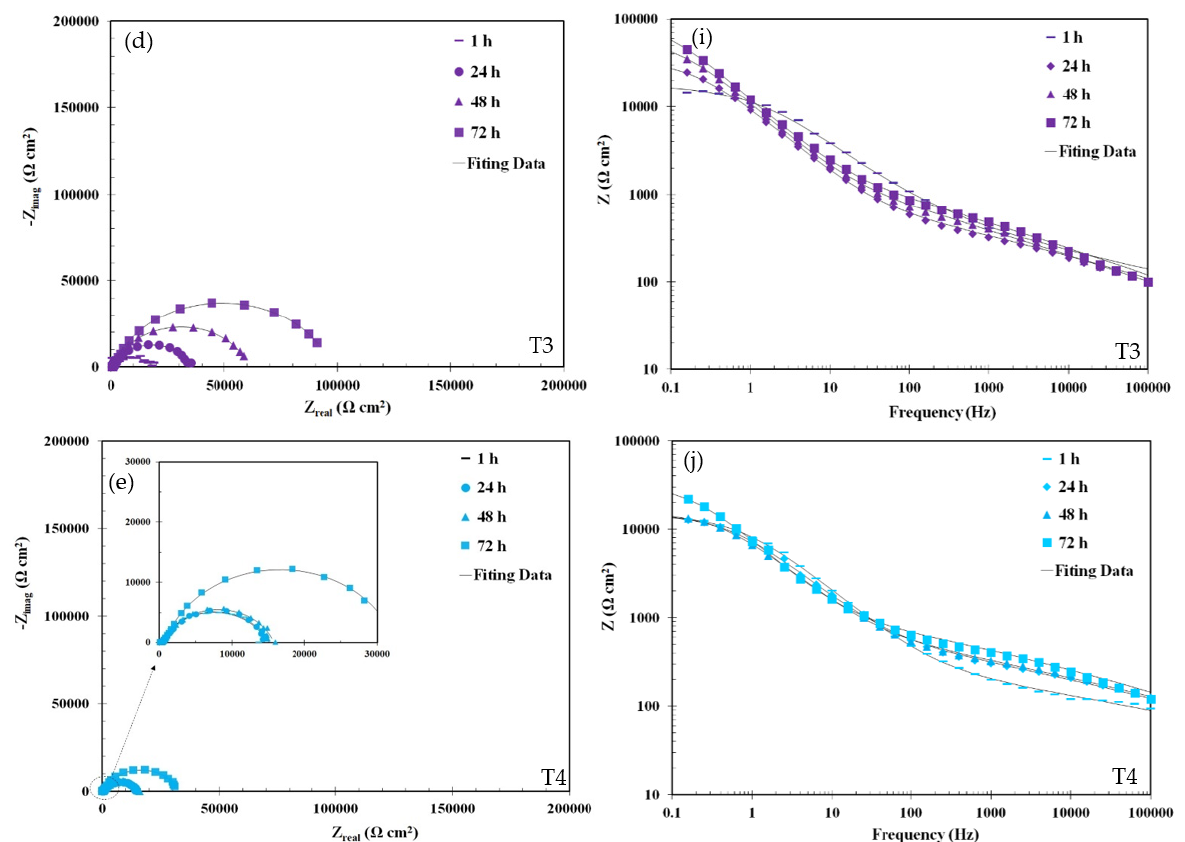
Figure 10. ( a – e ) Nyquist, and ( f – j ) Bode plots of PEO-coated specimens at various concentrations of TiO2: T0= 0 g/L, T1= 1 g/L, T2= 2 g/L, T3= 3 g/L, and T4= 4 g/L.